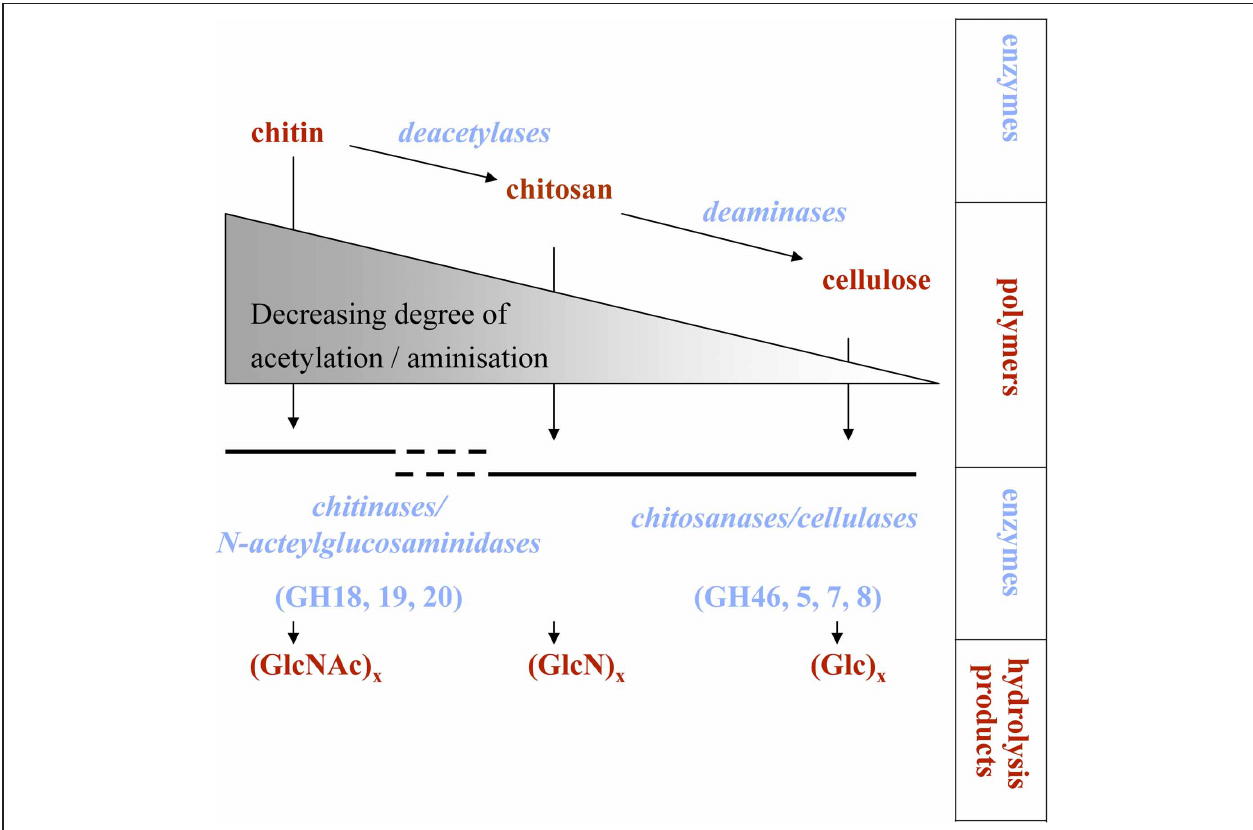
FIGURE 1 | Processes involved in chitin degradation. If deacetylation and deamination processes are very active, chitosan or possibly even cellulose-like molecules might be produced. GH, glycoside hydrolase family; GlcNAc, N-acetylglucosamine; GlcN, glucosamine; Glc, glucose.